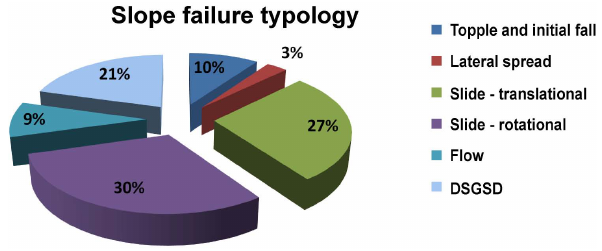
Fig. 2. Review of the total 129 monitored slope failure types from 86 sites that were included in the study. Note that 31% of them formed complex failures (modified classification of Cruden and Varnes, 1996).